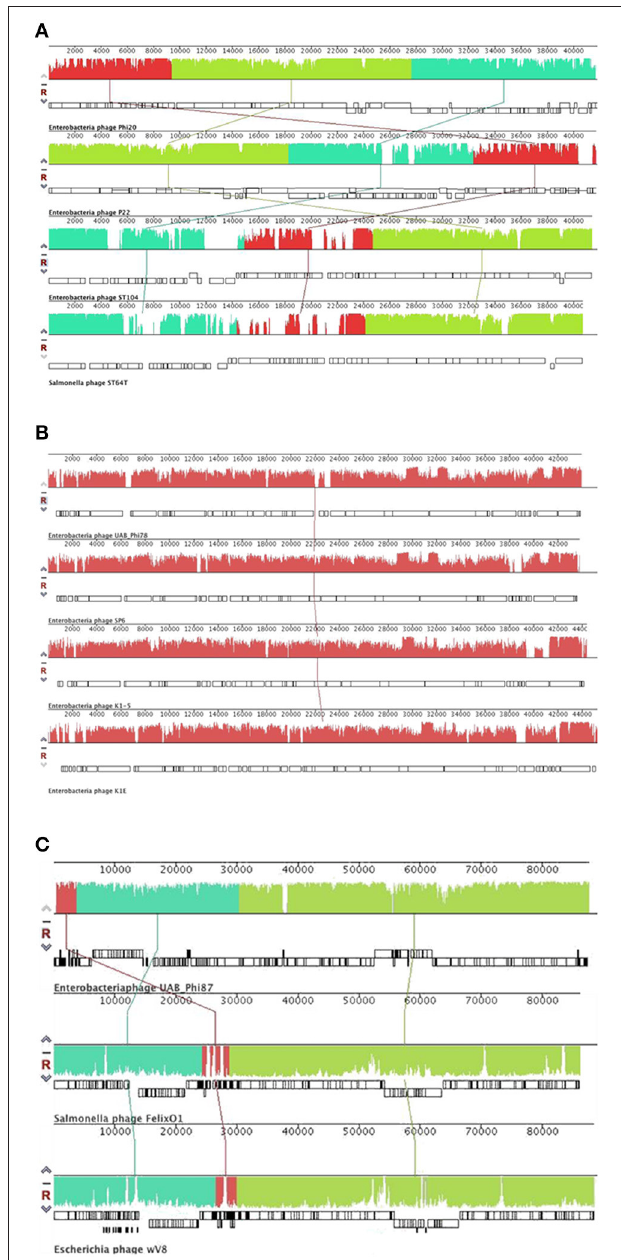
FIGURE 2 | Alignment of the UAB_Phi20 (A), UAB_Phi78 (B), and UAB_Phi87 (C) genomes and their counterparts belonging to the Podoviridae and Myoviridae families using Progressive MAUVE. The names of the different bacteriophages are indicated under their maps. Colored blocks correspond to regions of nucleotide similarity which is indicated by its height and regions with a lack of homology are outside these blocks or indicated in white inside the blocks. The tRNA genes are indicated by the filled gene blocks.